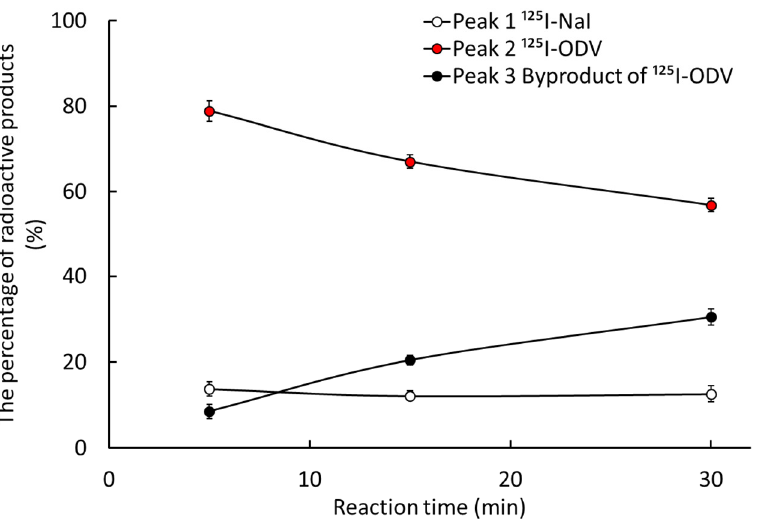
Figure 2. The percentages of peak areas from the HPLC chromatogram. Peak 1 was 125 I-NaI. The percentage of peak 2 decreased and the percentage of peak 3 increased depending on the reaction time, so peak 2 was 125 I-ODV and peak 3 was a byproduct of 125 I-ODV.